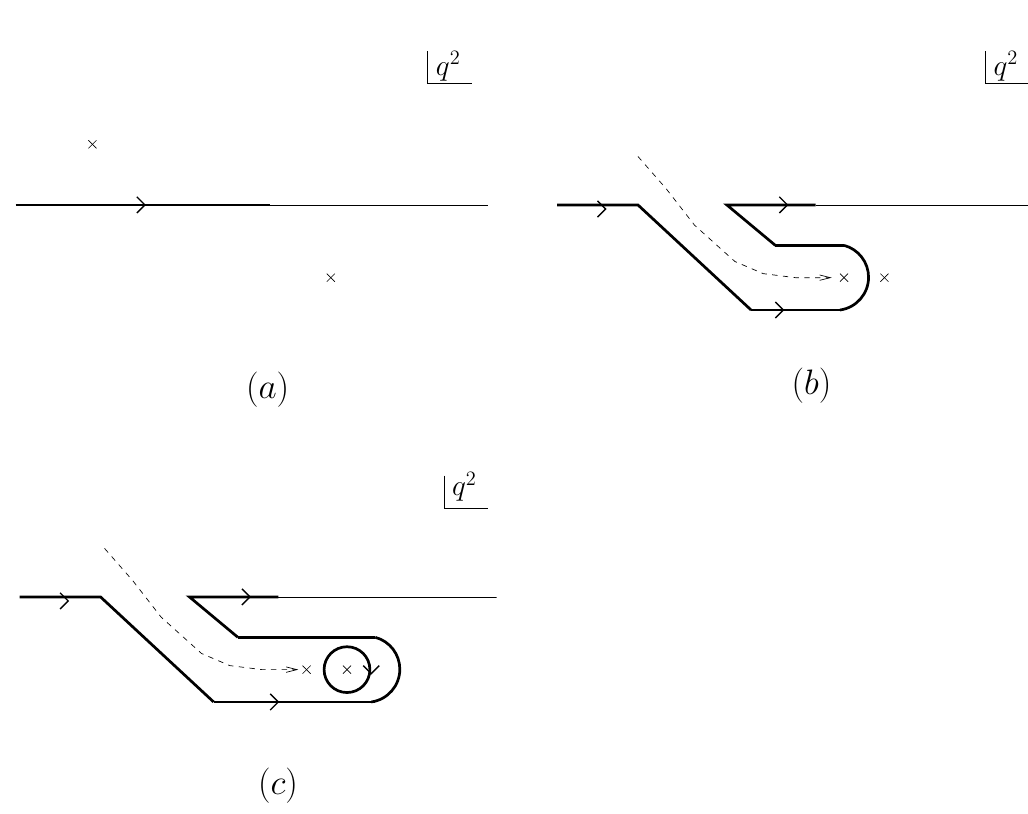
Figure 2 . (a) Original position of singularities with undistorted contour in q 2 plane; (b) singularity movement as z z 0 pinching the contour; (c) equivalent contour consisting of regular and a singular → (circle)